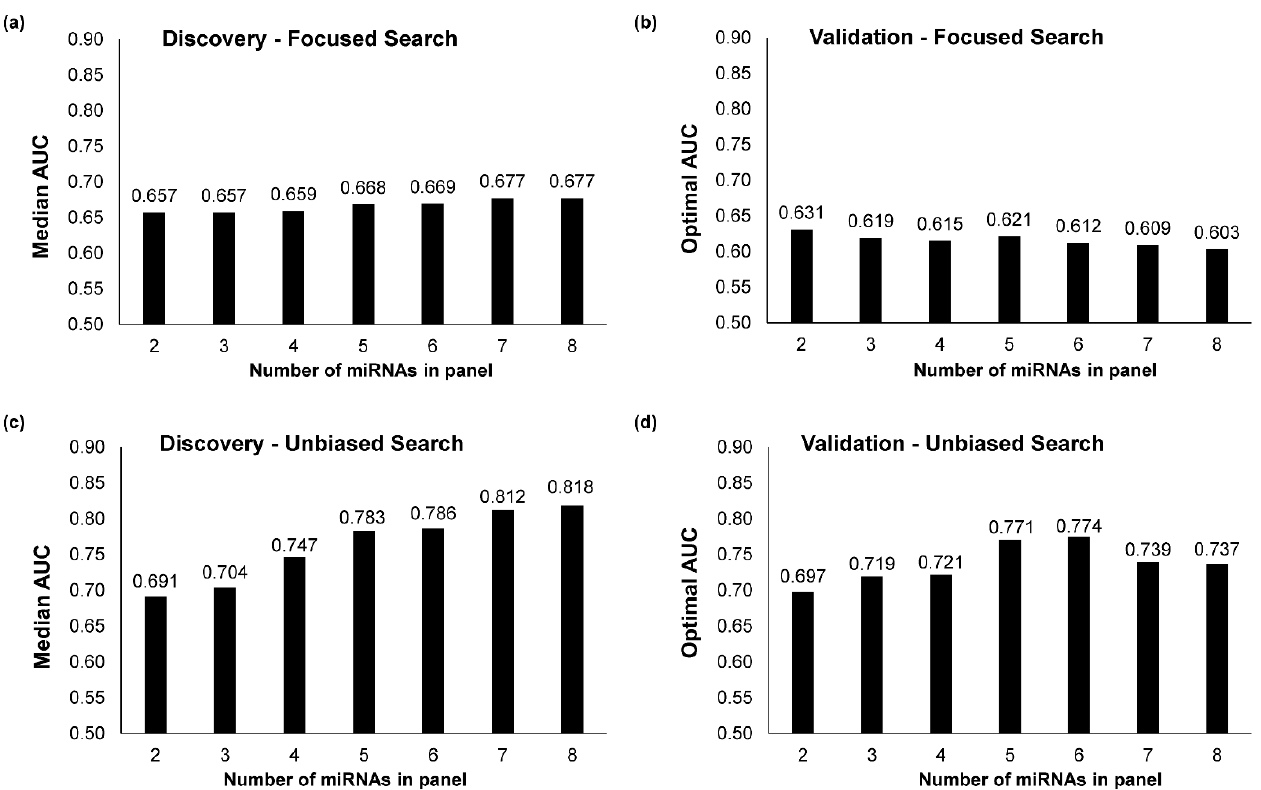
Figure 2. Biomarker panel building. Median AUC values for multi-miRNA biomarker panels identified through ( a ) a focused search and ( c ) an unbiased search in the Discovery Cohort. AUC values for optimal multi-miRNA biomarker panels from the ( b ) focused search and ( d ) unbiased search validated in the Validation cohort. The focused search refers to a search among the 8 top-ranked differentially regulated miRNAs only while the unbiased search expanded the search to all 324 miRNAs analysed in this study.